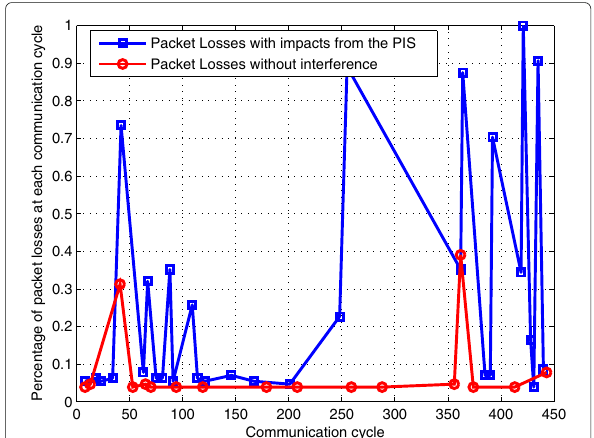
Fig. 5 Percentage of packet losses at each communication cycle when interference does or does not exist